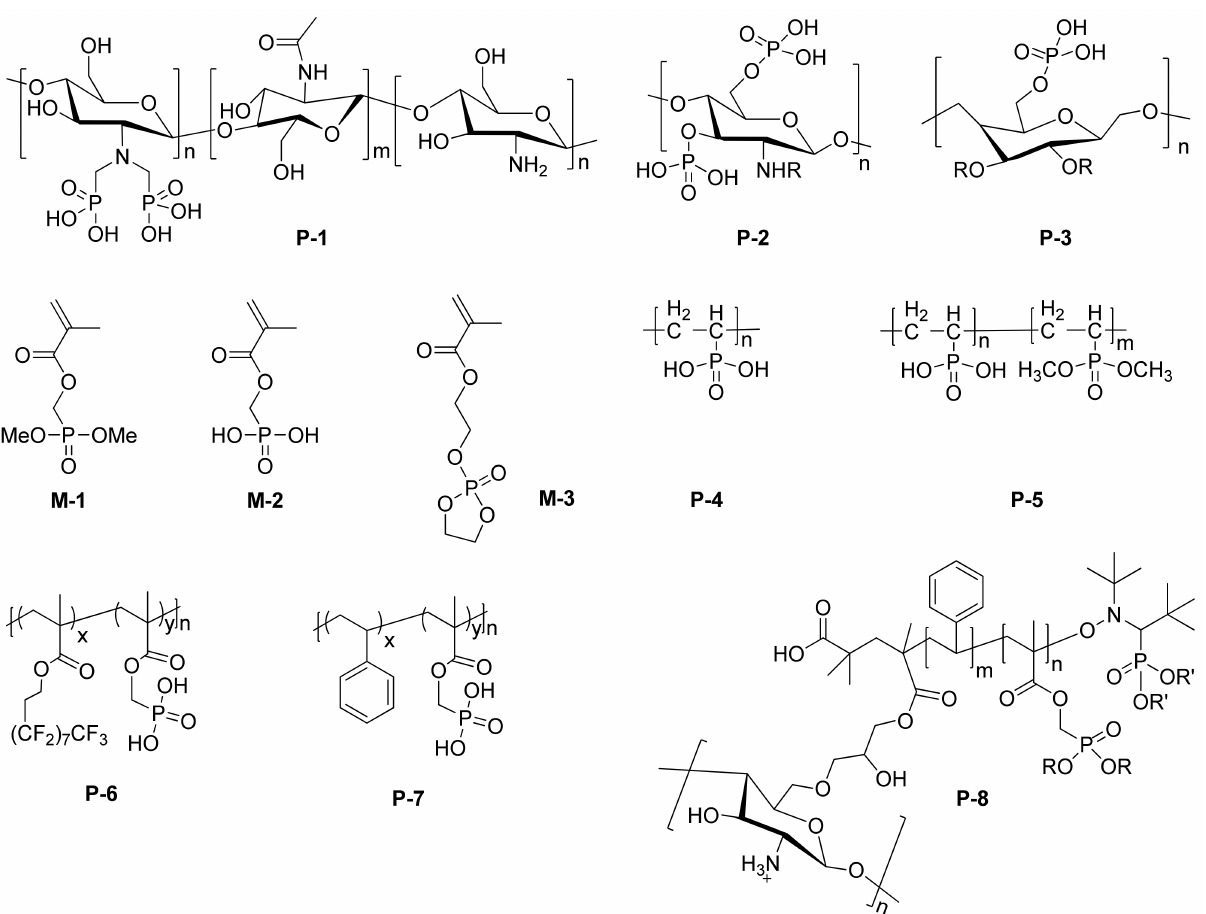
Figure 5. Chemical structures of typical phosphorus-containing polymeric inhibitors (P1–P8) and monomers